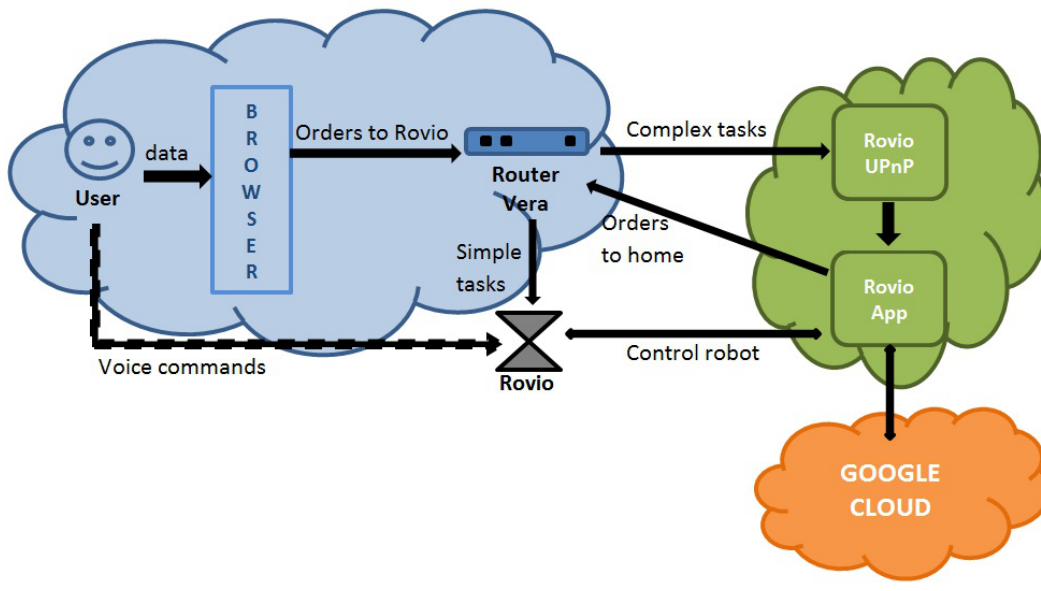
Figure 4. Entities’